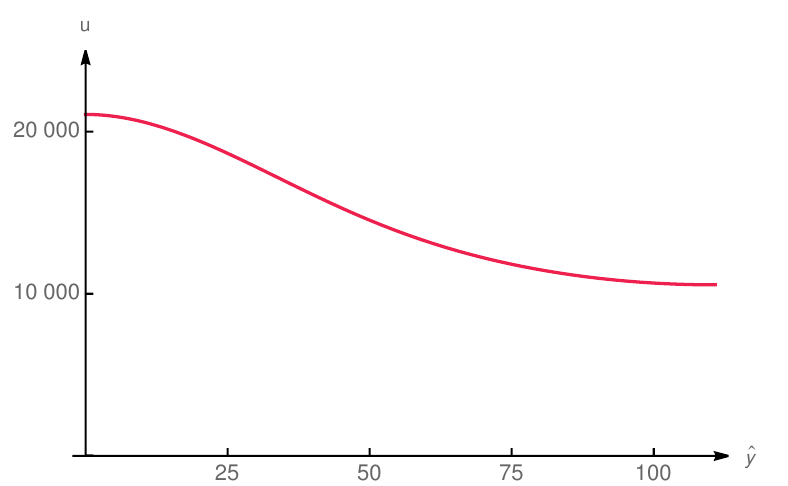
Figure 5: A smooth solution to the non-linear version of the Constraint equation (3.17) in the filled the geometry